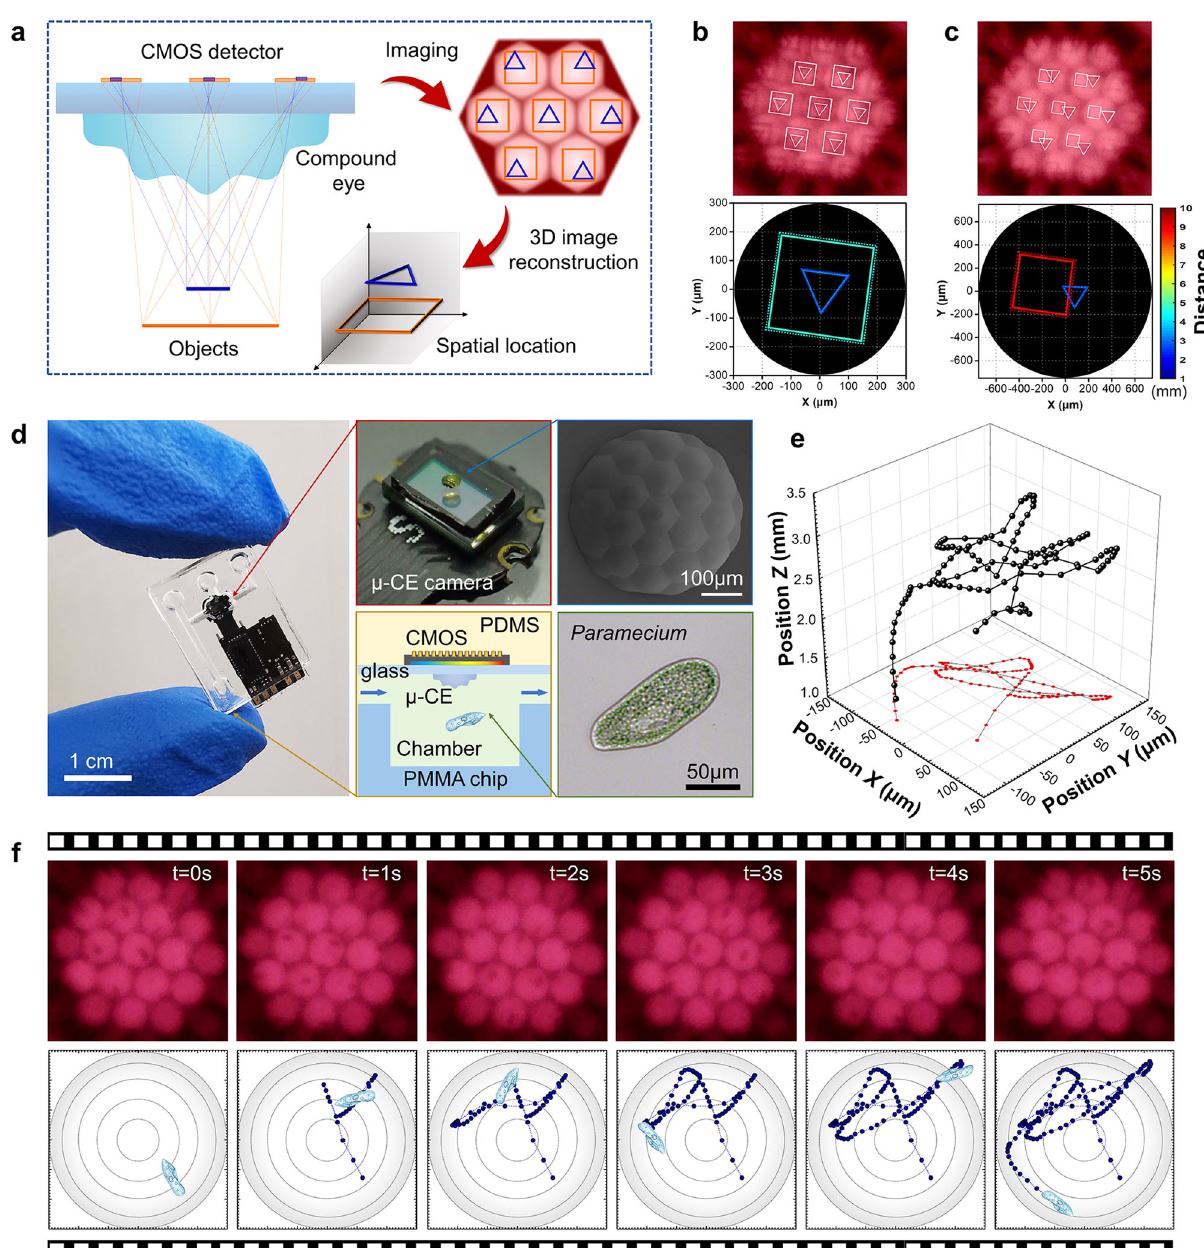
Fig. 5 | On-chip camera for living microorganisms. a Schematic diagram of the basic principle for microscopic 3D reconstruction based on a μ -CE camera. b , c Imagescapturedbythe μ -CEcamera(top)andthe3Dreconstructionresultsof the target objects (amicro-squareand a triangle) attwodifferent spatial positions. Dashed and solid lines represent real and reconstructed spatial positions, respec- tively. d Photograph of the on-chip camera system (left), the μ -CE camera (top-